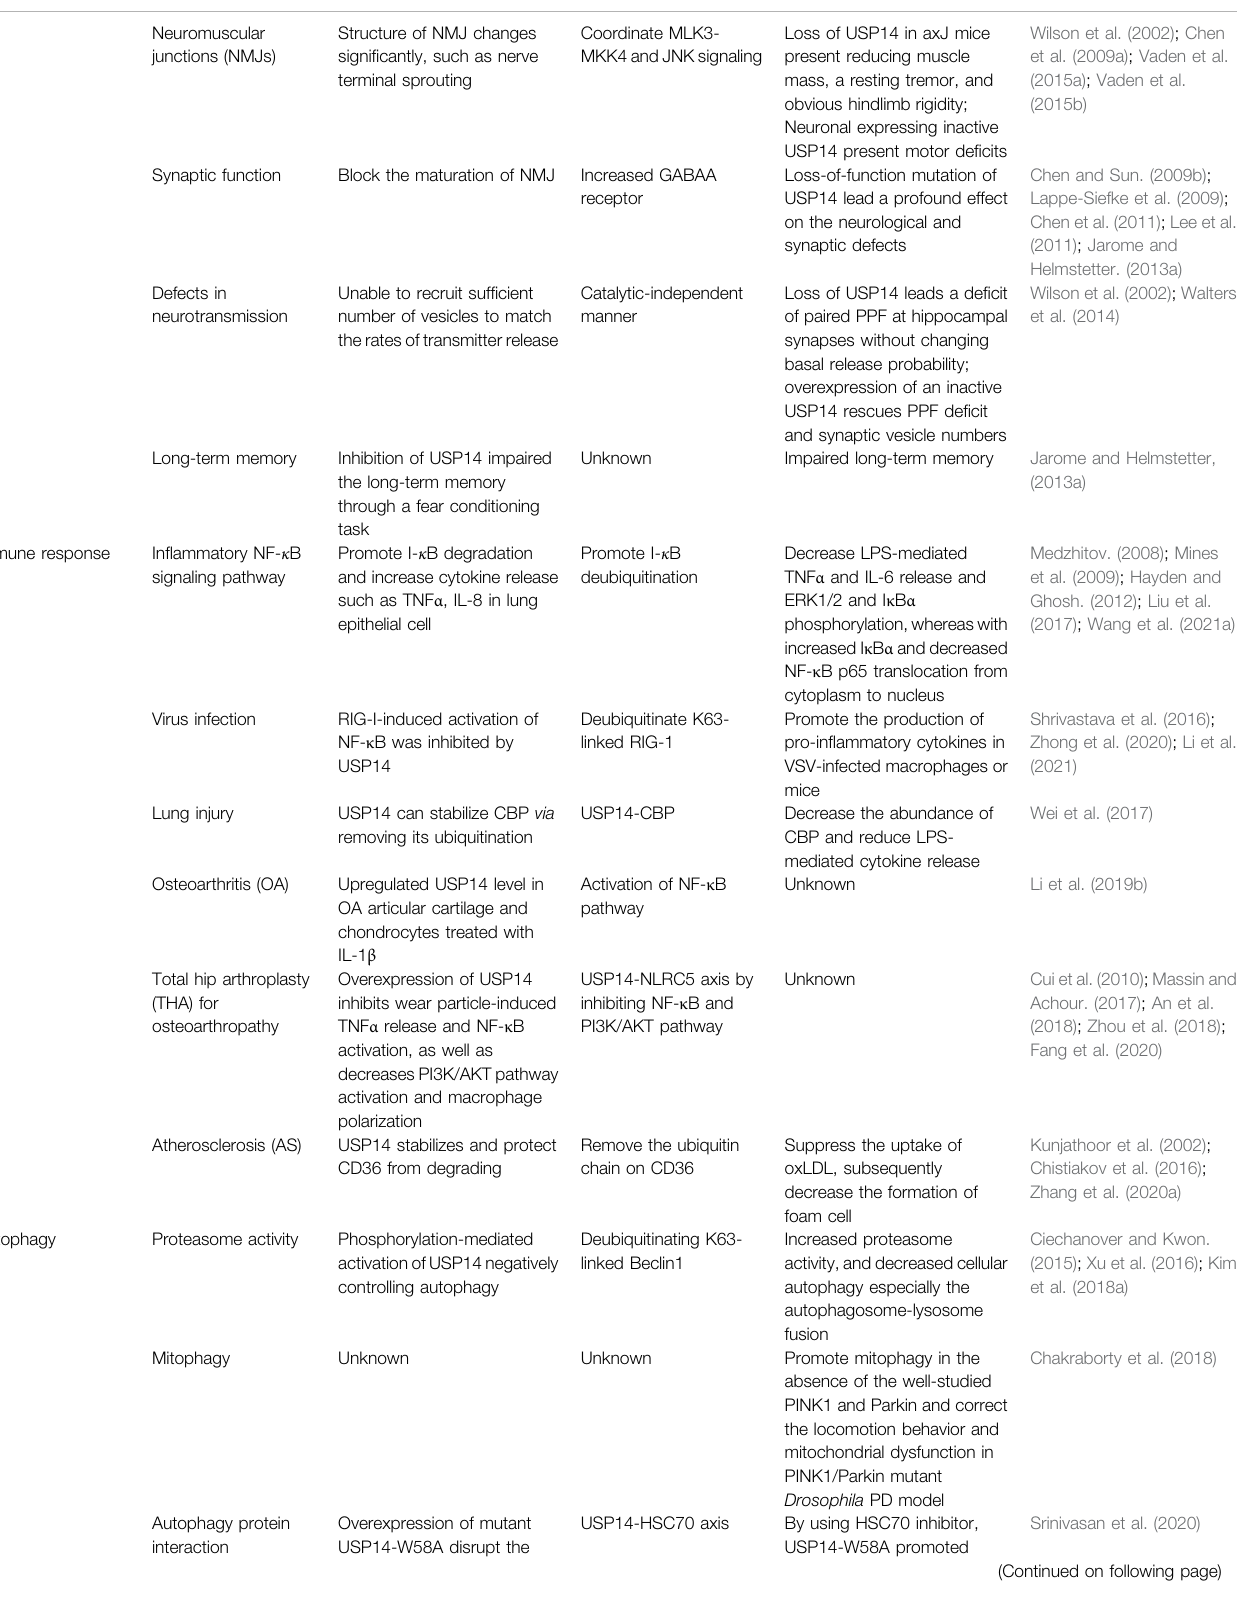
TABLE 2 | ( Continued ) USP14 connected with various pathophysiological processes via different signaling